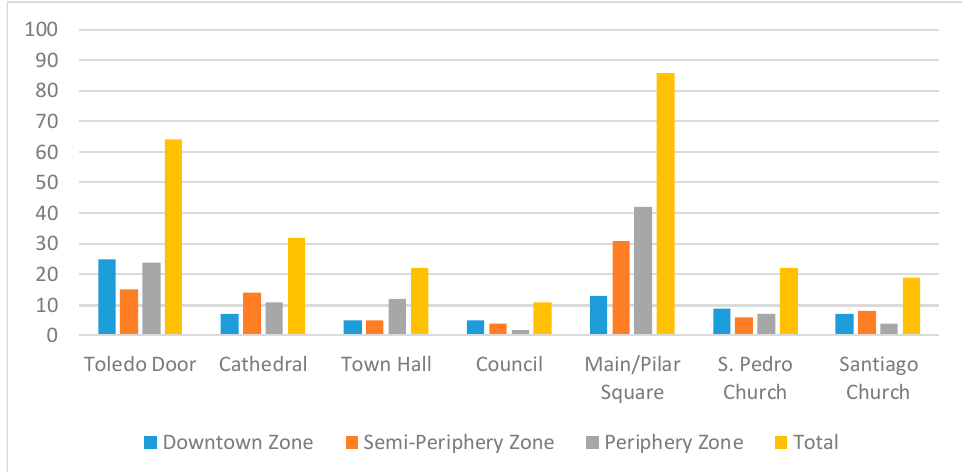
Figure 4. Results of answers relating to cultural heritage. Source: Own work.